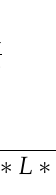
Table 3. Module properties and operation conditions.